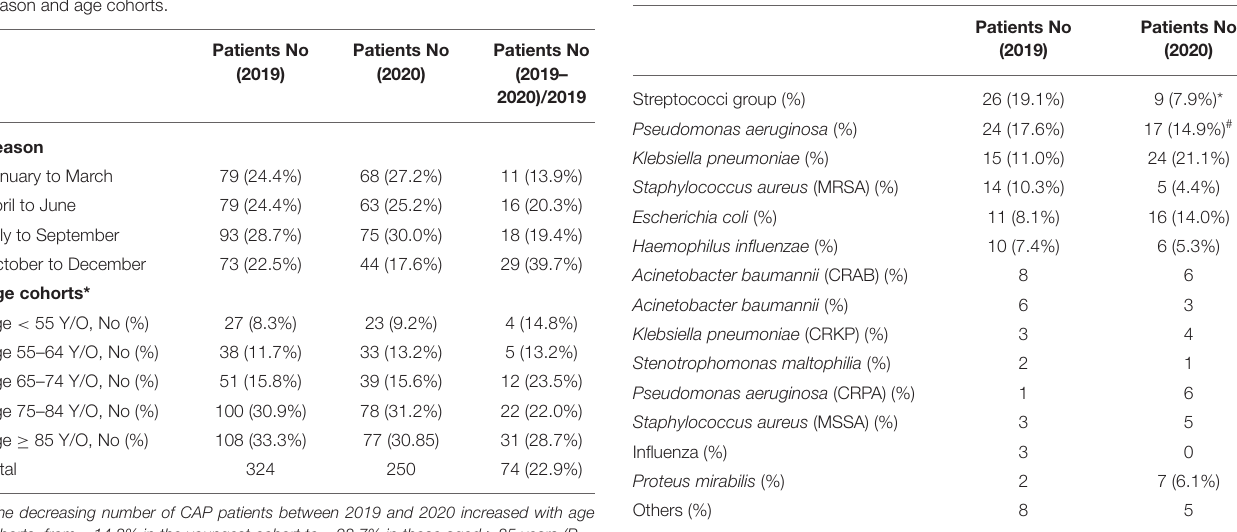
TABLE 2 | Identified pathogens in community-acquired pneumonia